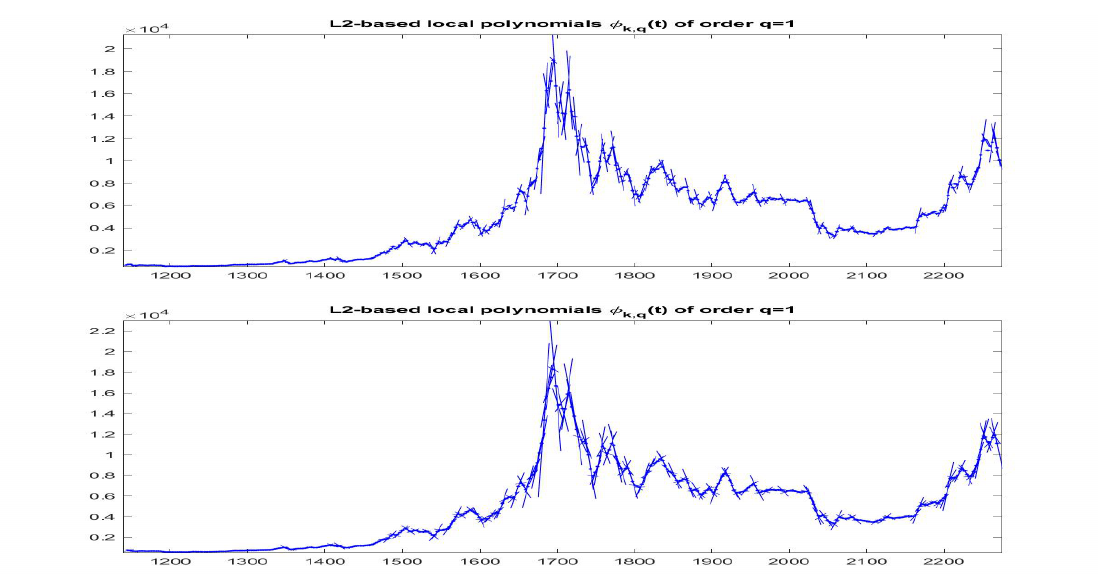
Figure 15. L 2 -norm F-transform components of order 1 for Bitcoin series. The fuzzy r -partition is P a with r = 4 ( top picture) and r = 7 ( bottom